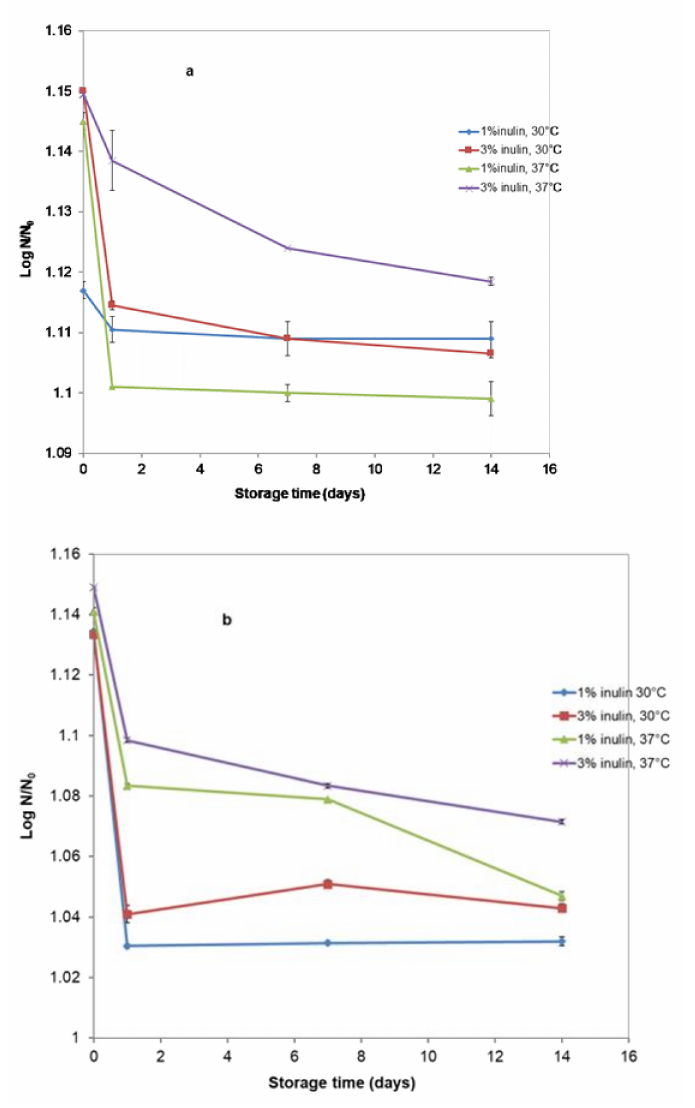
Figure 4. Viability of probiotic bacteria in the stored samples. ( a ) Samples with SBS; ( b ) Samples with